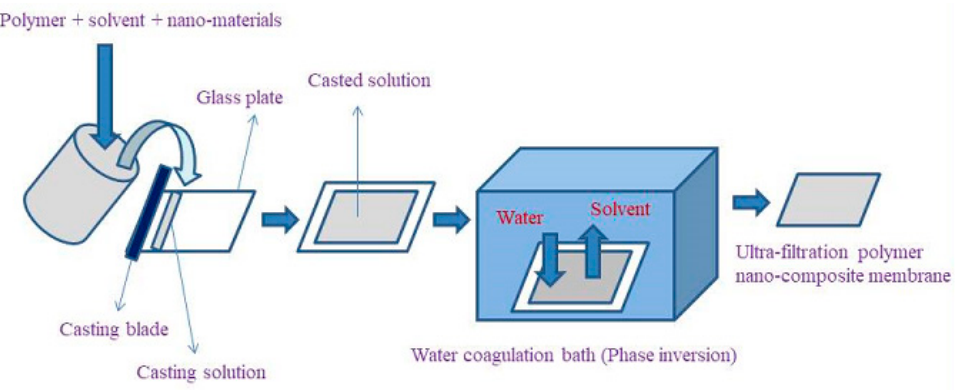
Figure 8. Schematic representation of the phase inversion method.